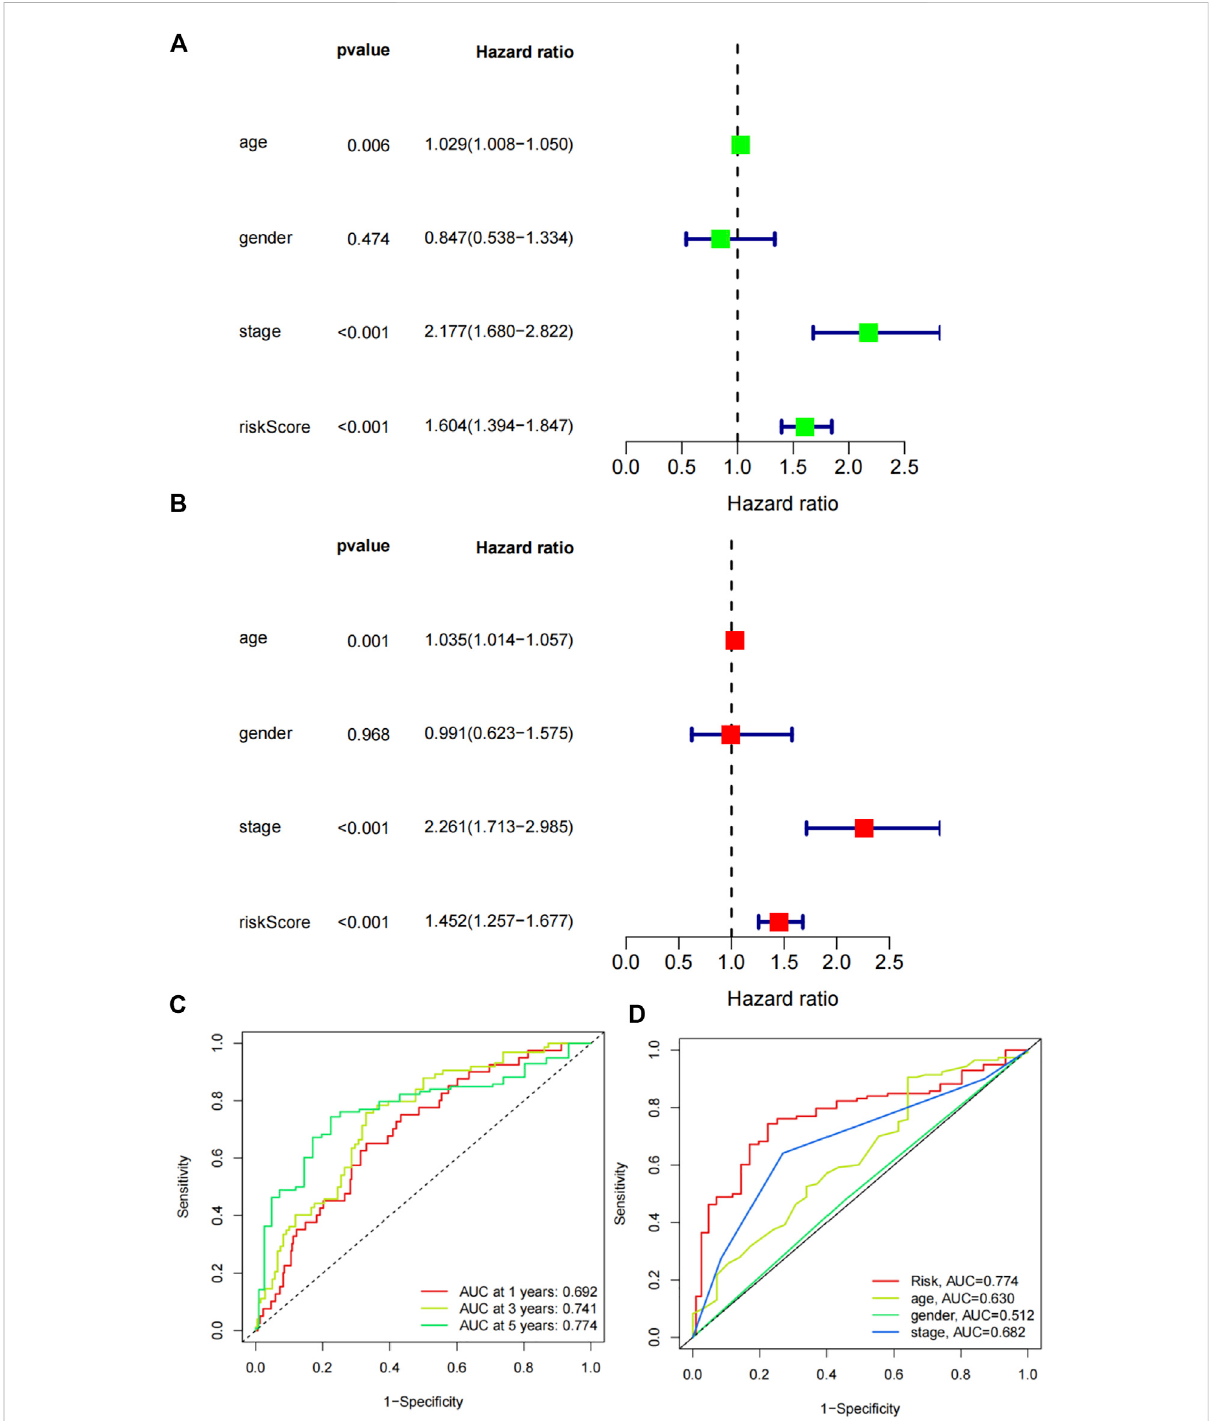
FIGURE 6 Predictivecapabilitiesoftherisksignature. (A) UnivariateCoxregressionanalysisoftheriskscoreandvariousclinicalfactors. (B) MultivariateCox regressionanalysis of the clinical factors and riskscore. (C) Time-dependent ROC curvesof the risk signature in predicting the survival. (D) Multi ROC curves of the risk signature and clinical